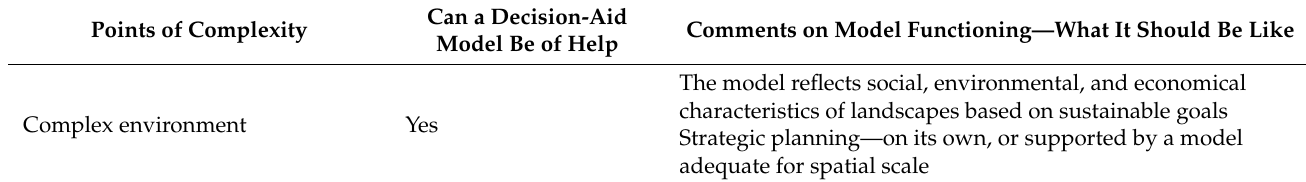
Table 2. Complexities 2, opportunities and requirements of a decision-aid model, related to complexi- ties in considering the spatial